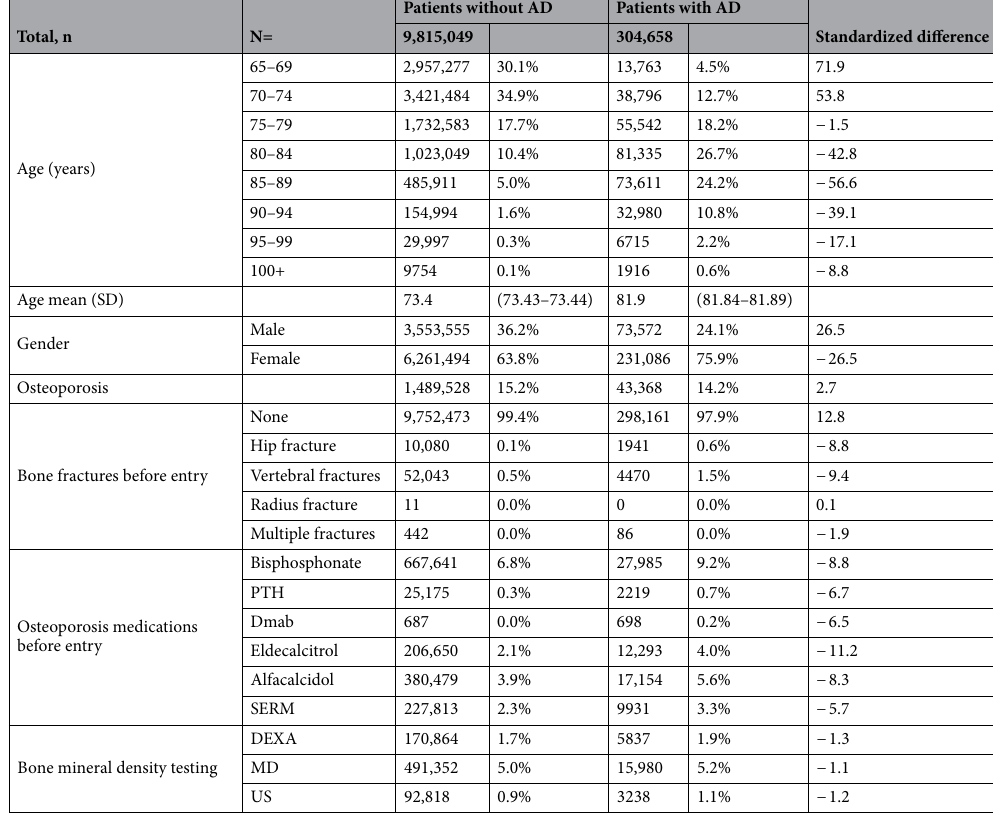
Table 1. Baseline characteristics of the patients with and without AD. AD Alzheimer’s dementia, SD standard